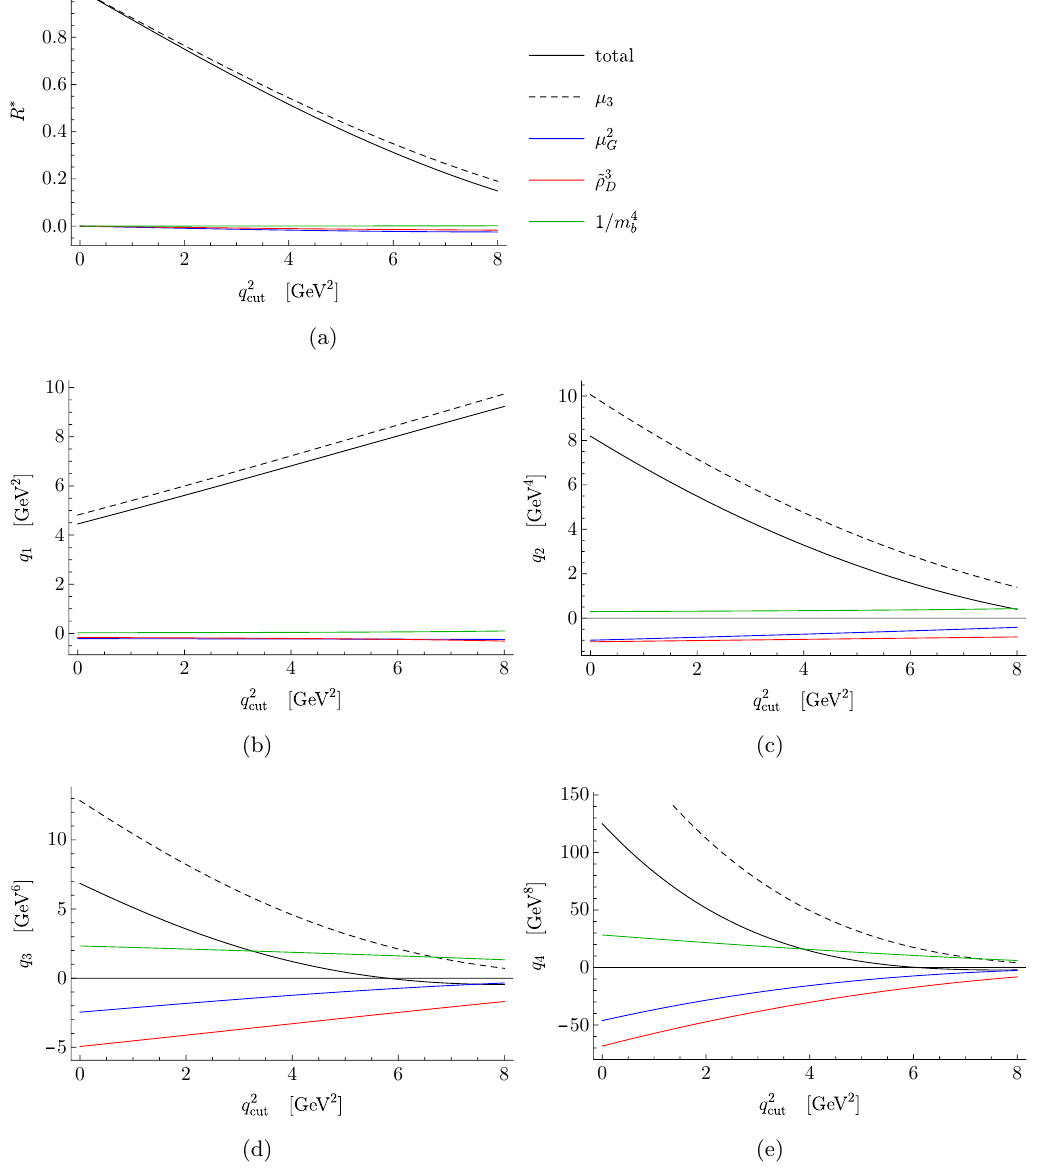
Figure 2 . Dependence of the ratio R (cid:3) and the (cid:12)rst four centralized moments on the di(cid:11)erent orders in the 1 =m b expansion. Black dashed, blue and green lines represent the contributions from (cid:22) 3 , (cid:22) 2 and ~ (cid:26) 3 , respectively. The sum of the 1 =m 4 G D are the (cid:12)nal predictions for R (cid:3) and the moments including terms up to order 1 =m 4